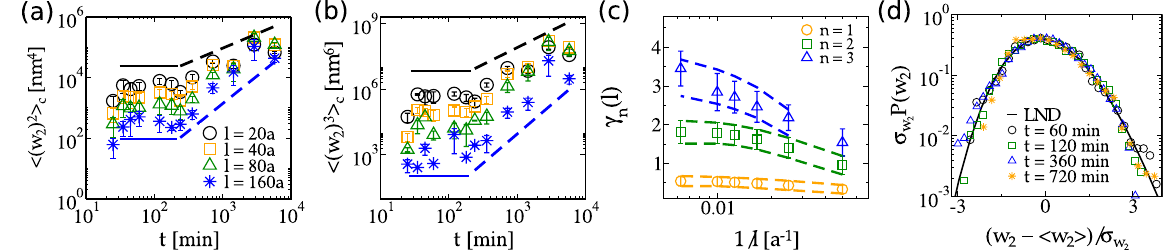
Figure 3. Temporal evolution of the second ( a ) and third ( b ) cumulants of width distributions, P ( w 2 ), calculated for windows of different lateral sizes l . Solid and dashed lines are guide to eyes indicating the PSS and KPZ regime, respectively. Top (black) and bottom (blue) dashed lines have the slope of the curves for l = 20 a and l = 160 a , respectively. ( c ) Exponents γ n ( l ) as a function of 1/ l . ( d ) Rescaled width distributions for CdTe surfaces (symbols), at several growth times and calculated for l = 80 a , along with the LND (solid line). Here, . 2 σ ≡ w ( ) w c 2 2